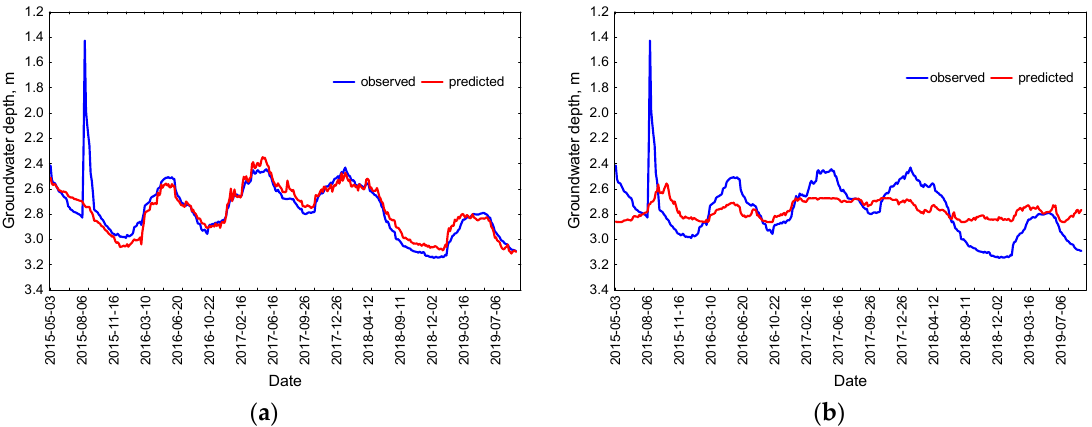
Figure 2. Observed and predicted groundwater levels (GWLs) (m) with SVR time series in the N-8 well in the test subset for the best ( a ) and the worst ( b ) combination of predictors.